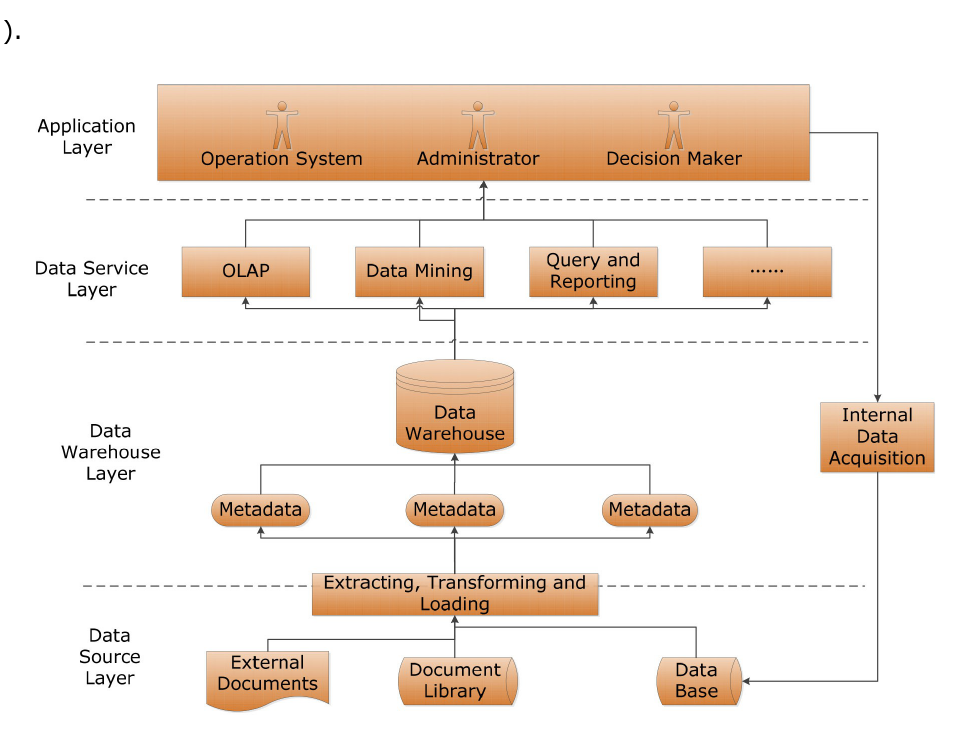
Figure 2. Four levels of container dispatching